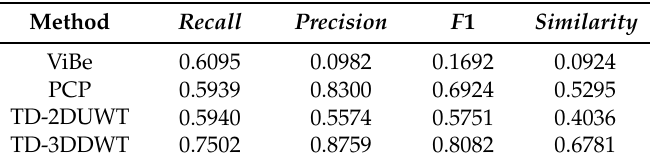
Table 5. Comparison of average metrics for TC96.